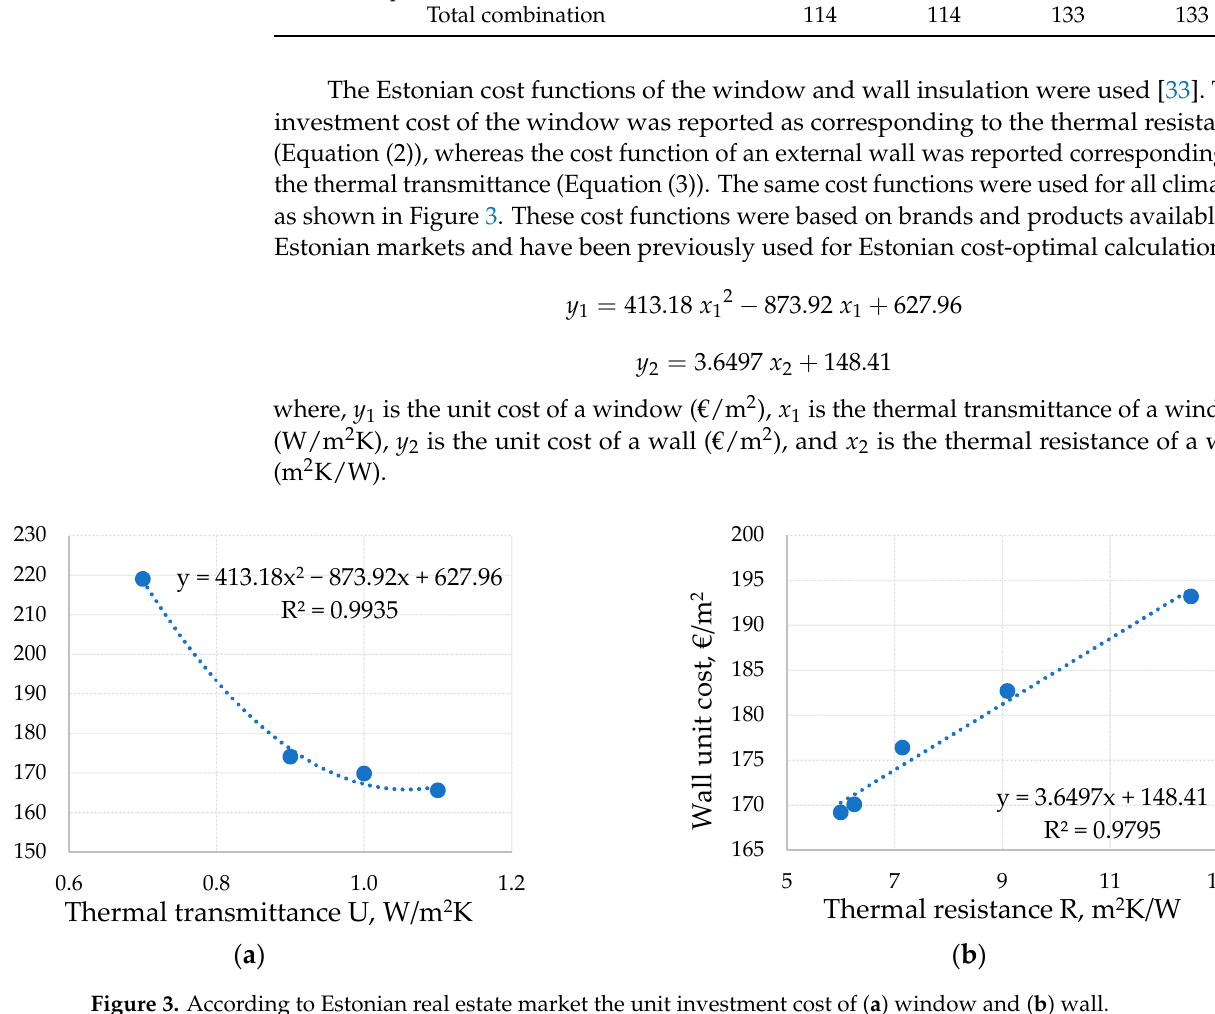
Table 2. Input data of parametric run for a single floor and a whole building model.